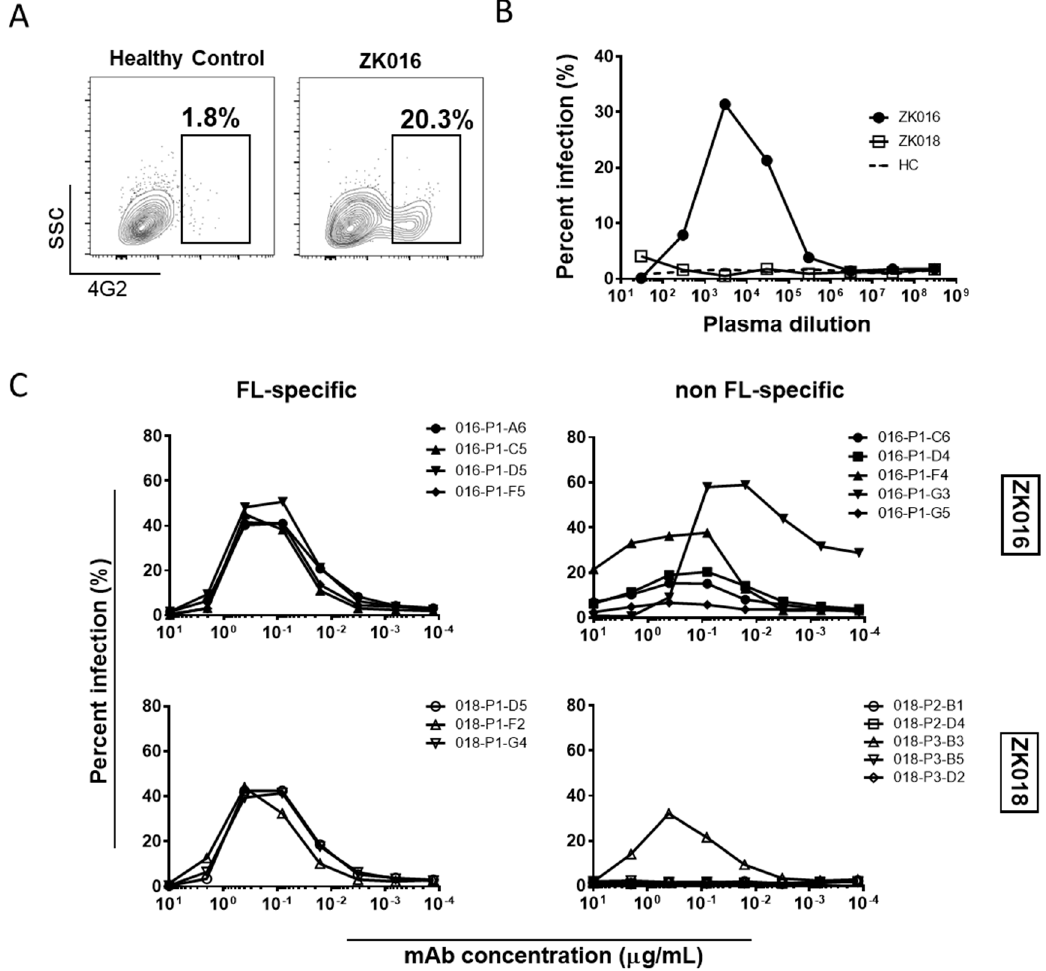
Figure 6. ZIKV plasmablast responses enhance DENV2 infection in vitro. ( A ) Representative flow cytometry plots comparing ADE activity of plasma from ZK016 vs. healthy control. Boxed population represents DENV2-infected cells based on positive 4G2 staining. Plots shown display ADE at plasma dilution of 1:3000. ( B ) DENV2 ADE activities of plasma from ZK016, ZK018 and a flavivirus-naïve healthy donor (dotted line). ( C ) DENV2 ADE activities of FL-specific and non FL-specific mAbs from ZK016 and ZK018.